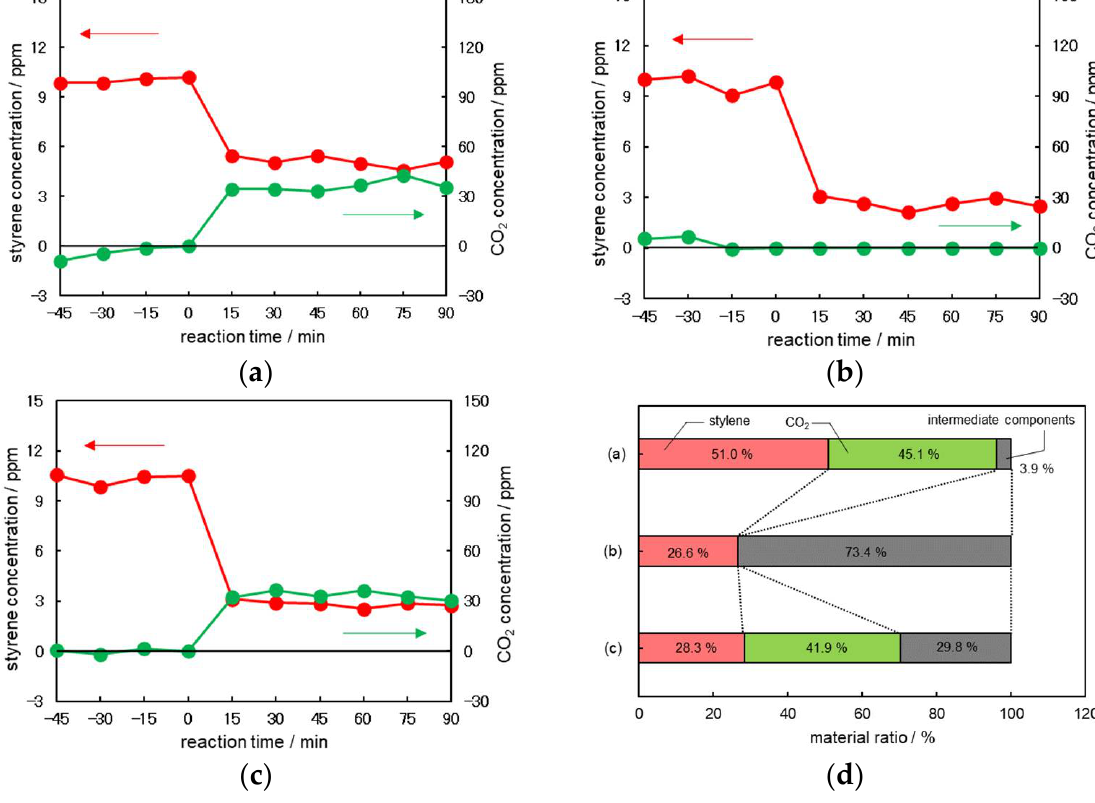
Figure 4. Typical data set of styrene removal (red) and CO 2 generation (green) by reaction with ( a ) photocatalyst + UV irradiation, ( b ) ozone + UV irradiation, ( c ) photocatalyst + ozone + UV irradiation, and ( d ) carbon material balance for each reaction (red: unreacted styrene components, green: generated CO 2 components, gray: generated intermediate components).